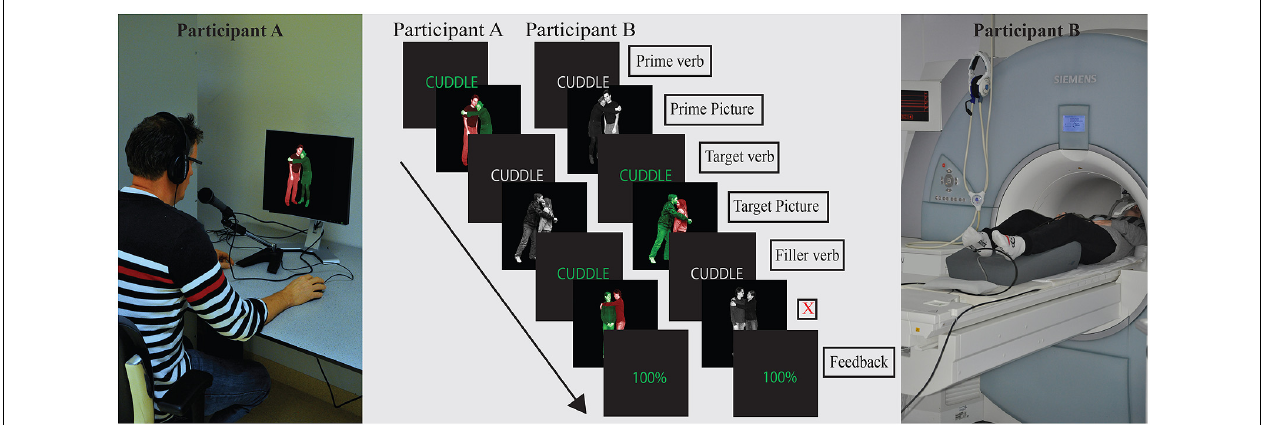
FIGURE 1 | Set-up of the experiment in the communicative context condition. Two participants – one in the MRI scanner, one in the behavioral experiment room – describe photographs to each other. (In the non- communicative context, there was only one – MRI – participant.)Trial struc- ture and task were identical in both conditions. Green verbs at the start of a trial indicated that a (color-coded) production photograph would follow; gray verbs indicated a (grayscale) comprehension photograph would follow.Verbs were presented to participants in Dutch (English translation is shown in the figure). Production photographs were color-coded to guide participants’ production: participants were instructed to name the green figure before the